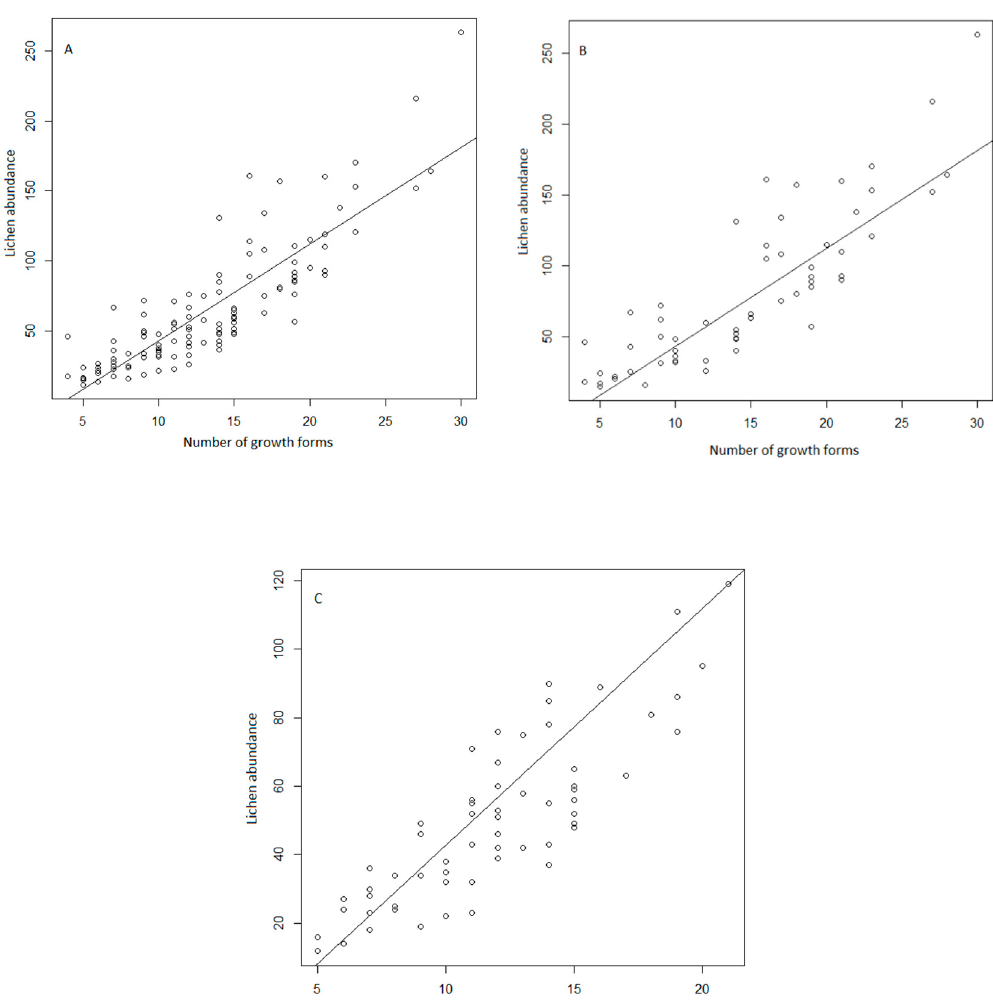
Figure 1. Results of the linear models based on the number of growth forms (x-axis) and epiphytic species abundance (y-axis) for: ( A ) All forests together (y = 6.896x − 26.109, n = 119, R 2 = 0.739), ( B ) Central-South American forests (y = 7.116x − 23.678, n = 58, R 2 = 0.742), and ( C ) European forests (y = 5.297x − 12.543, n = 61, R 2 = 0.713); p < 0.0001 in all cases.